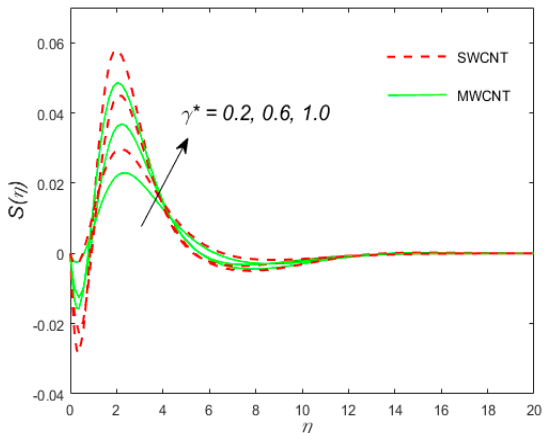
Figure 12. The variation of the micro rotation profile S ( η ) for the case of SWCNT and MWCNT versus the similarity variable for the distinct values of the material parameter K . Coatings 2020 , 10 , x FOR PEER REVIEW